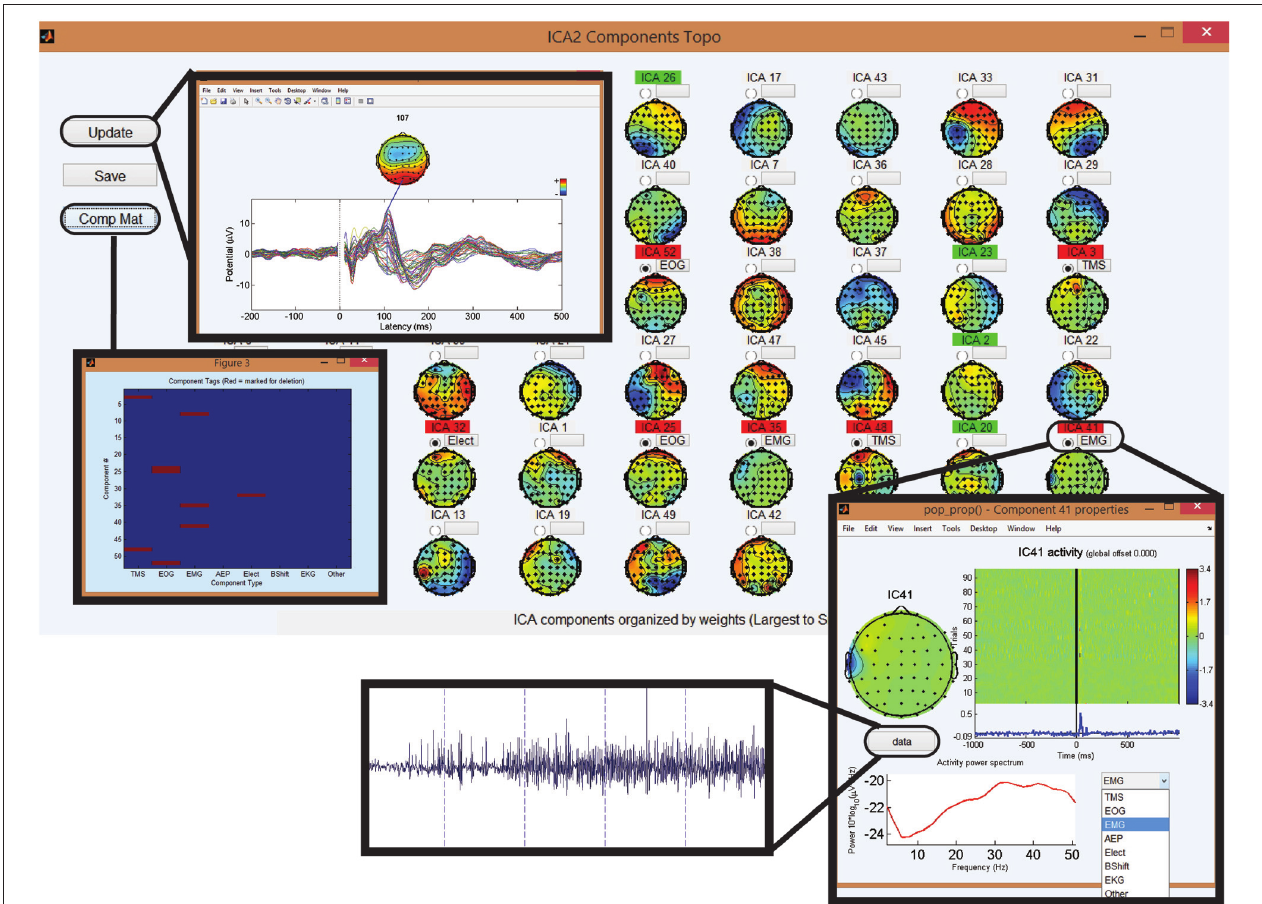
FIGURE 7 | Step 8 GUI for removing artifactual components in second round of ICA. Topographical display of the ICA components derived in the second round of ICA in order of variance (largest to smallest). Selecting the gray button above a component will display the temporal, spectral, and spatial characteristics of the corresponding component. Within this “child” GUI, selecting the data button will display the time domain characteristics of the ICA component over each trial. The user can identify the type of artifact using the drop-down menu. This marks the component for deletion. Viewing a component will highlight the component name in green, and marking it for deletion will highlight it in red. Update button on the top left of the main GUI displays the averaged butterfly plot of the EEG data assuming the deletion of the marked components. Comp Mat button on the top left of the main GUI is used to visualize the components marked for deletion for quality control ( x -axis is the component type and y -axis is the component